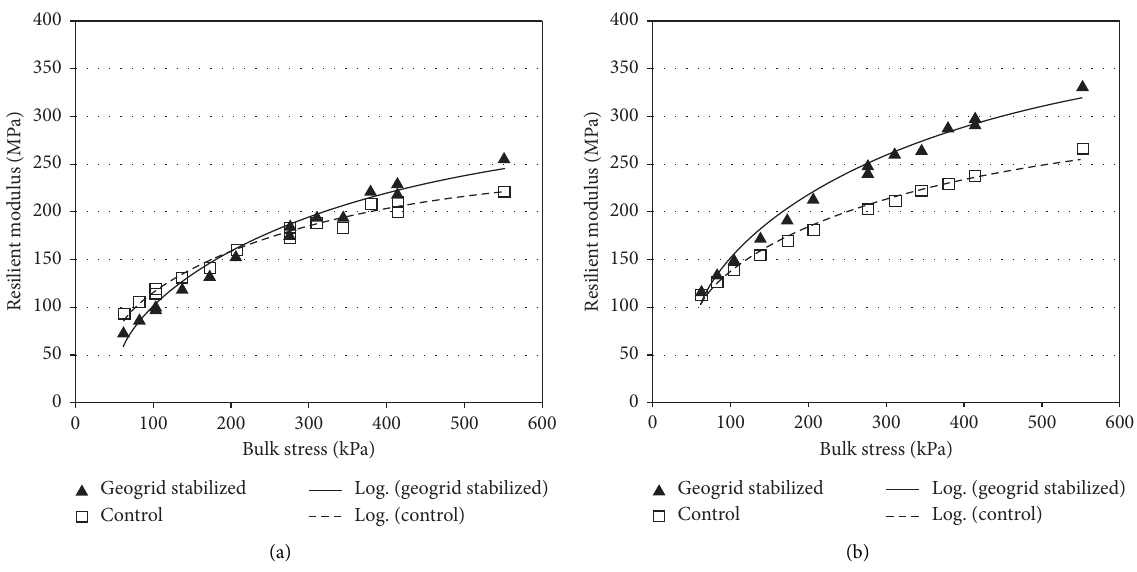
Figure 3: Resilient modulus from AASHTO T307 test. (a) Results of 0-day cured samples. (b) Results of 7-day cured